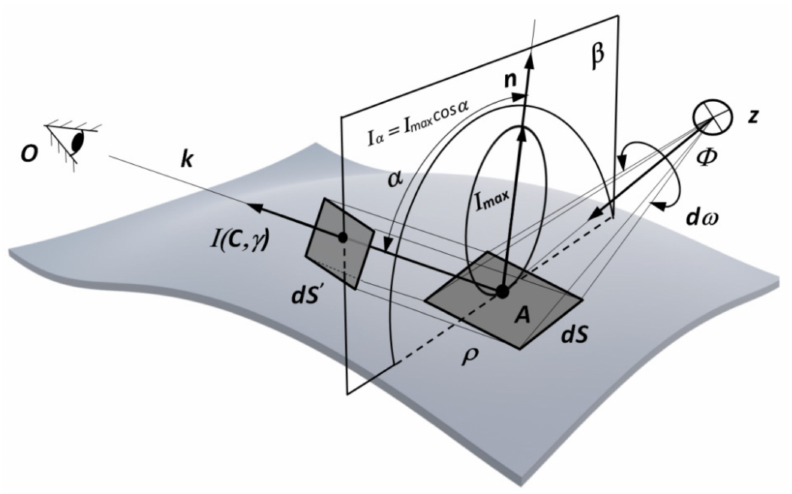
Figure 1. Graphic representation of the elementary ray reflection from a porous surface, compliant with Lambert’s cosine